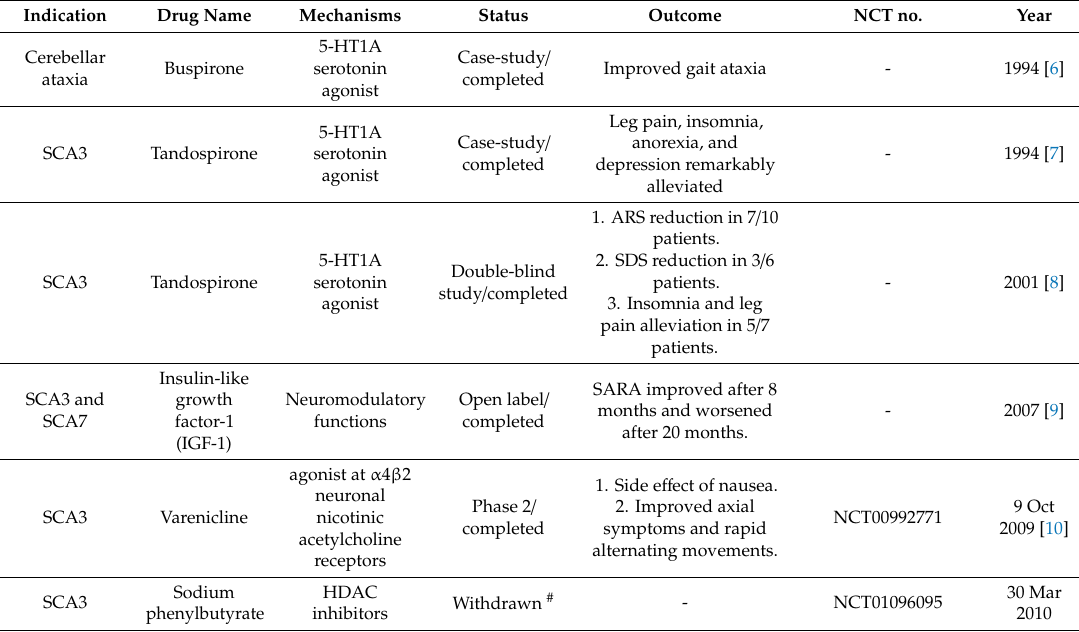
Table 1. Clinical trials for treating spinocerebellar ataxia type 3 / Machado–Joseph disease (SCA3 /